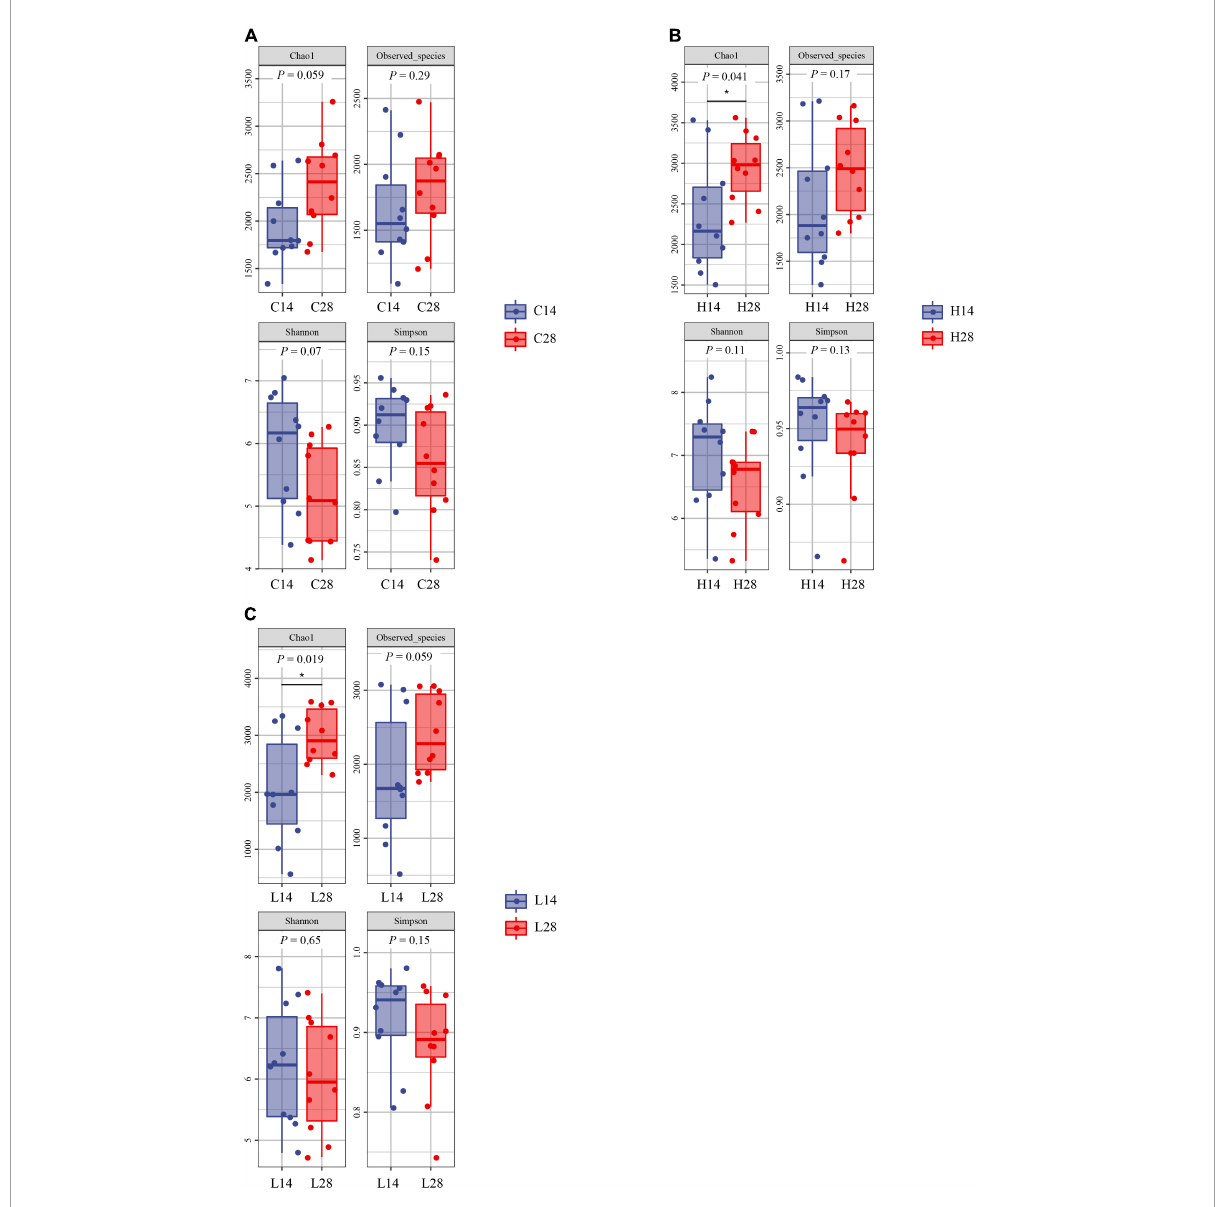
FIGURE3 Comparison of intestinal microbiome alpha diversity index of different experimental time points at the control group (A) , high temperature group (B) , and low temperature group (C) . The * denotes a significant difference ( P < 0 . 05 and < 0.01) between